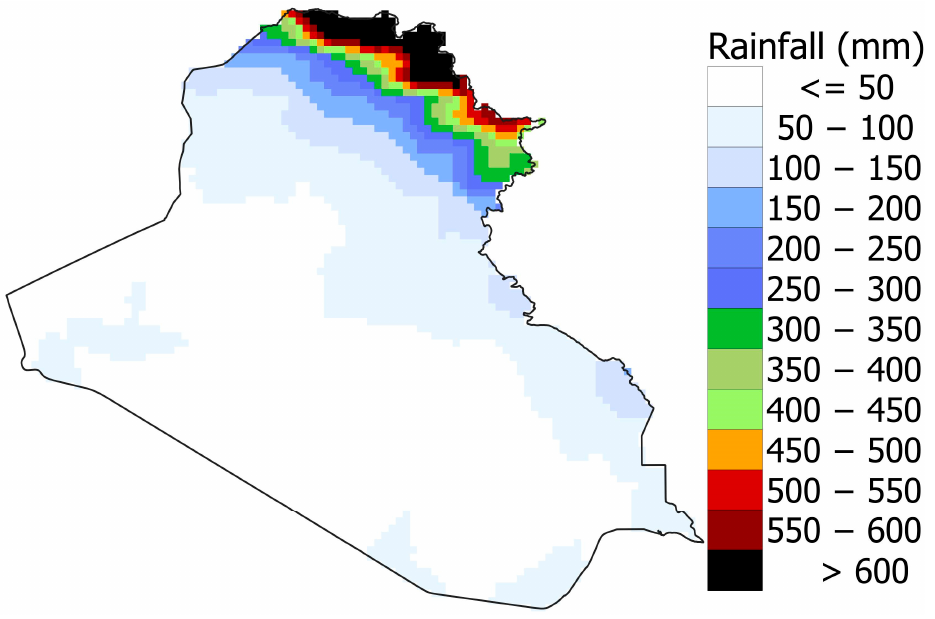
Figure 1. Topography of the study region.